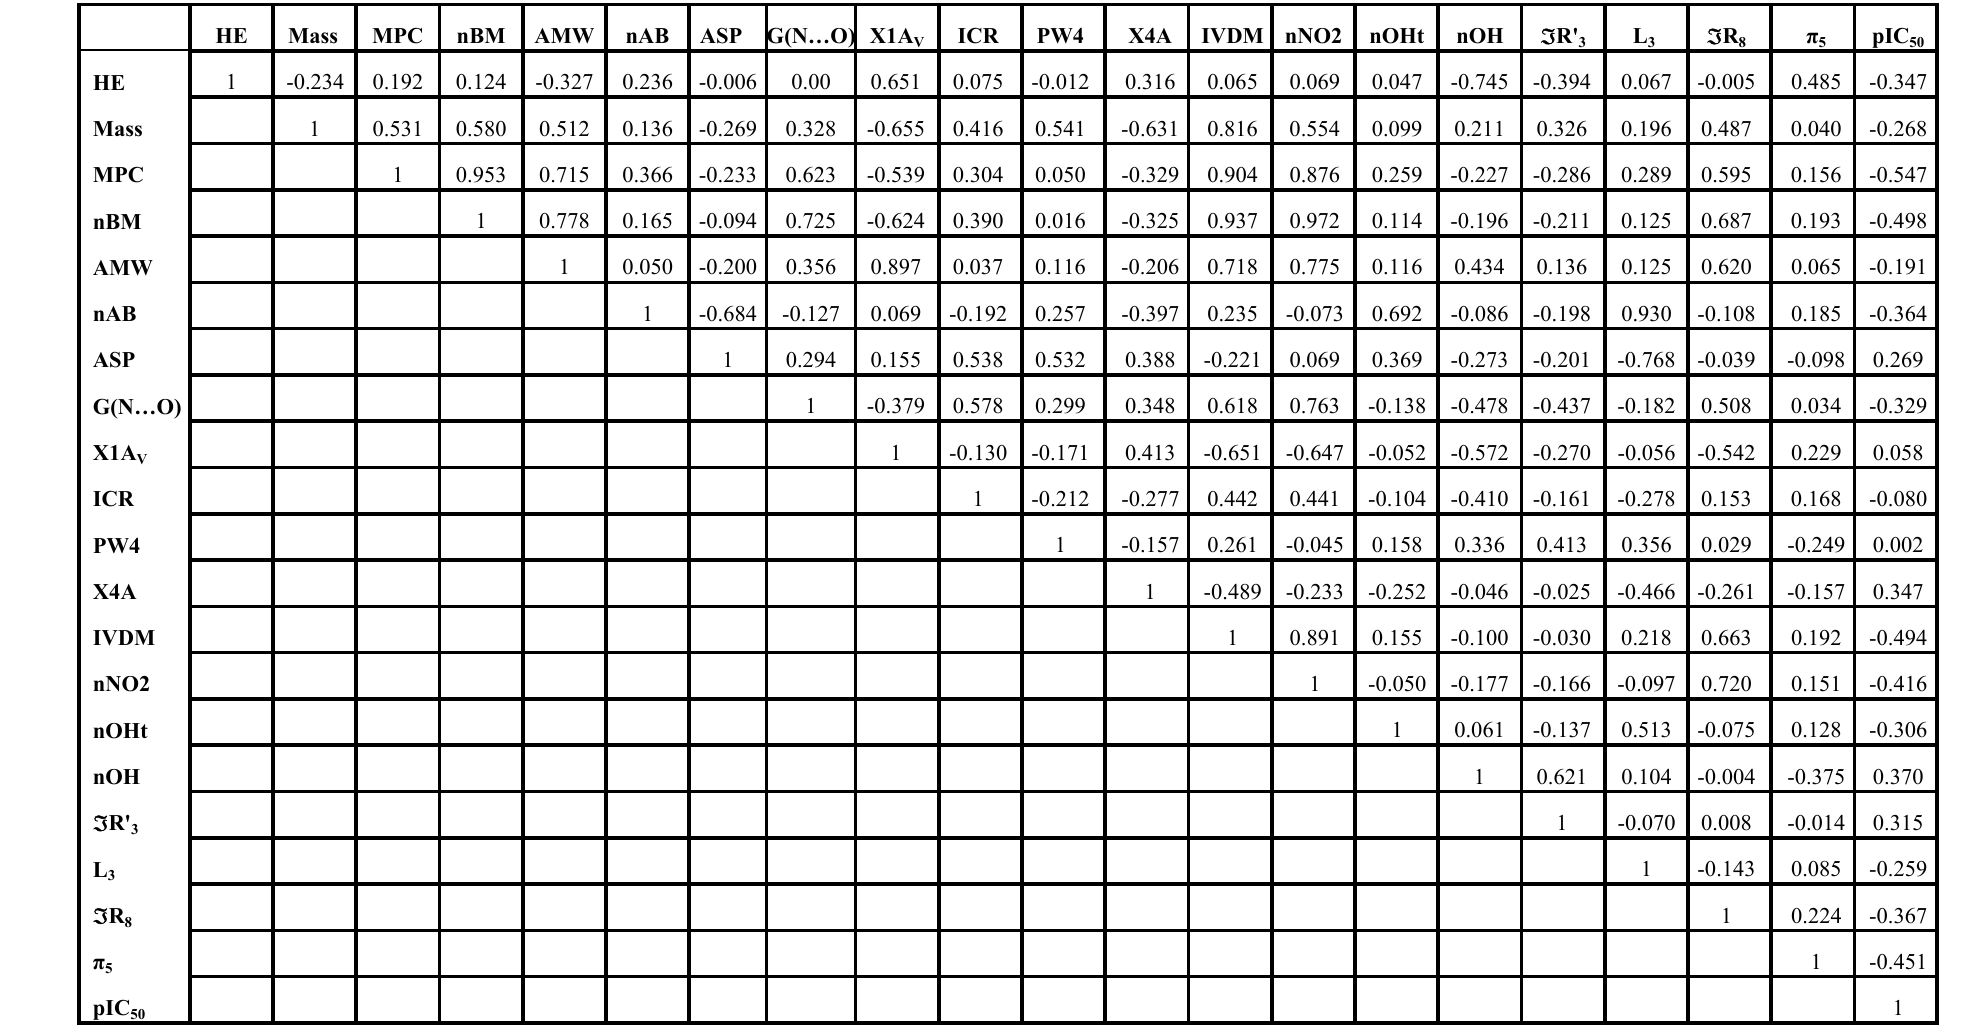
Table 4. Correlation coefficient (r 2 ) matrix for the descriptors of flavone derivatives used in the MLR